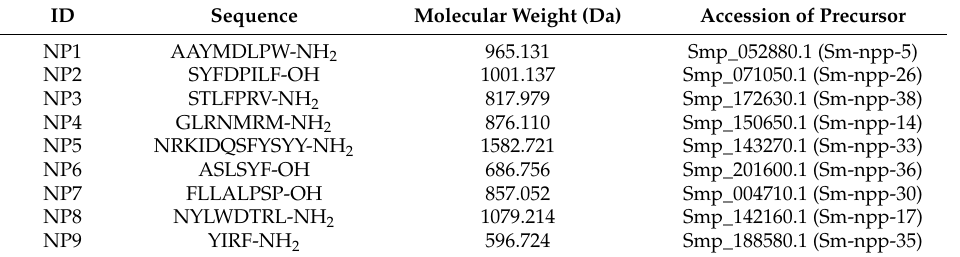
Table 1. Summary of putative neuropeptides